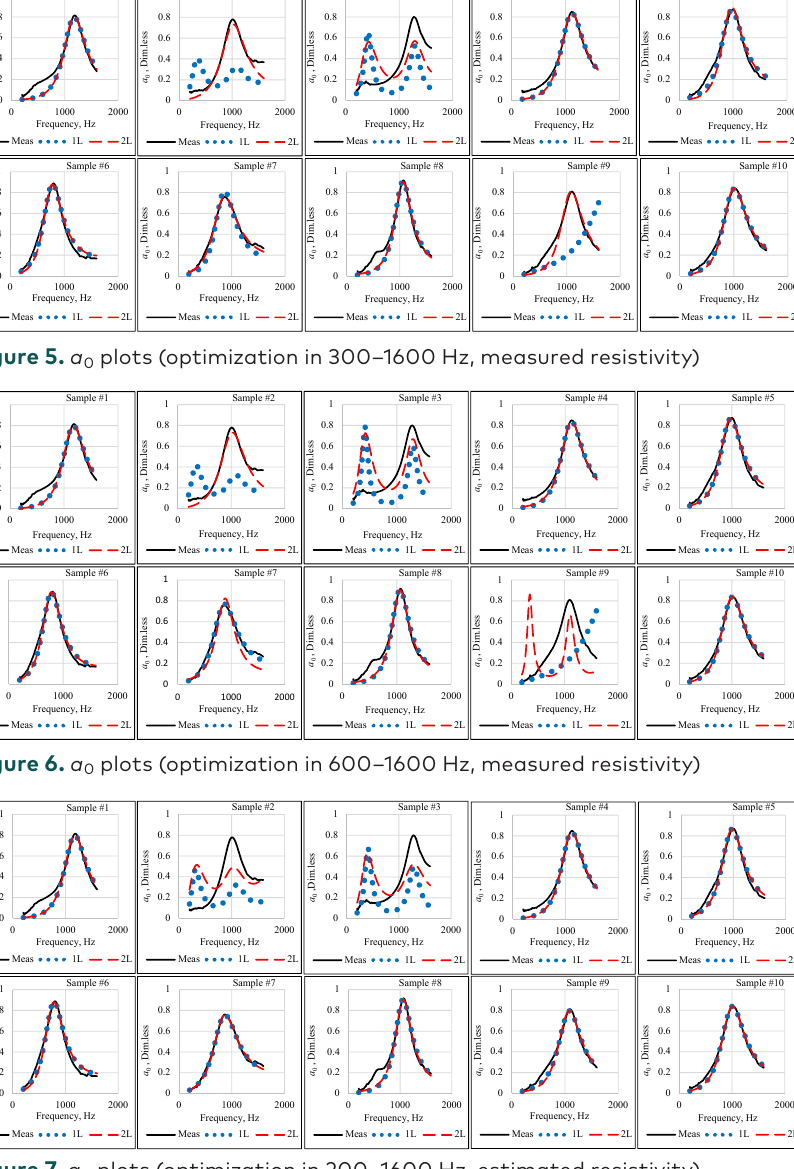
Figure 7. a 0 plots (optimization in 200–1600 Hz, estimated resistivity)